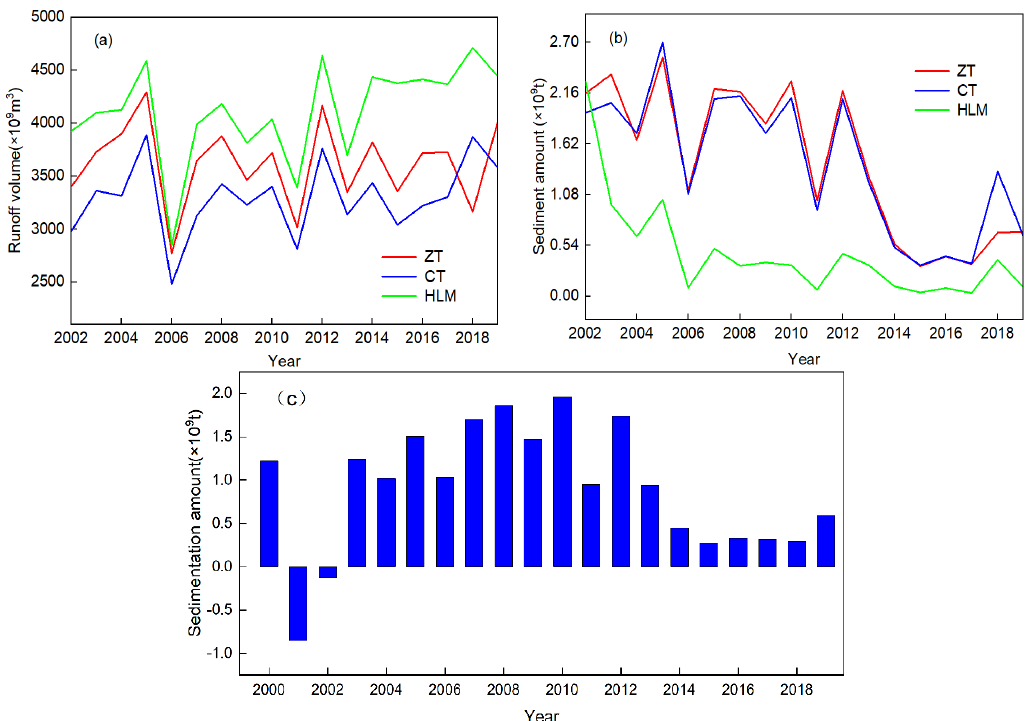
Figure 12. Water discharge and sediment amounts at the three key gauging stations in the different impoundment periods. ( a ) Annual runoff volume from 2002 to 2019, ( b ) annual sediment amount from 2002 to 2019 and ( c ) annual sedimentation amount from 2000 to 2019.